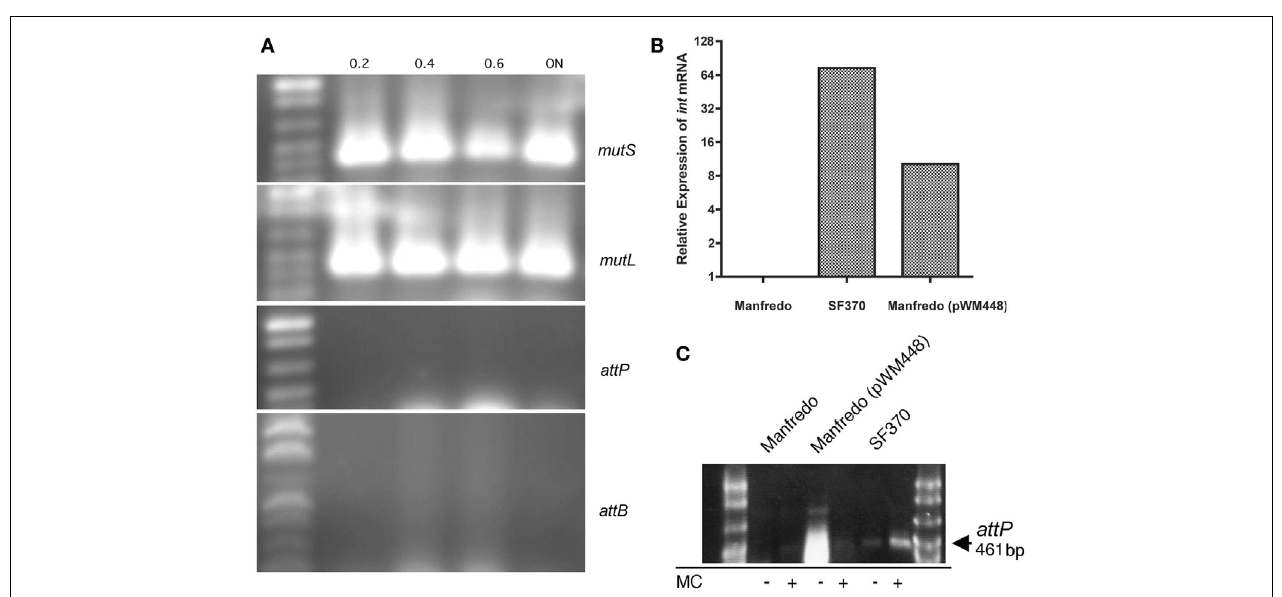
expression is absent from wild type Manfredo, and the target of the qRT-PCR amplification was the deleted region of the integrase ORF not present in Manfredo, confirming that expression was from the cloned SpyCIM1 gene. (C) The SpyCIM1 integrase mediates excision of SpyCIM5 in Manfredo. DNA was isolated from early logarithmic grown cells from Manfredo, SF370, or Manfredo (pWM448). PCR specific for attP , which is present only when the prophage-like element has excised from the mutS - mutL junction, produces no product in wild type Manfredo but appears after introduction of pWM448. Mitomycin C (MC), while stimulating the excision of the SpyCIM1 in strain SF370, inhibits the formation of attP in Manfredo (pWM448), suggesting inhibition of CAMP promoter